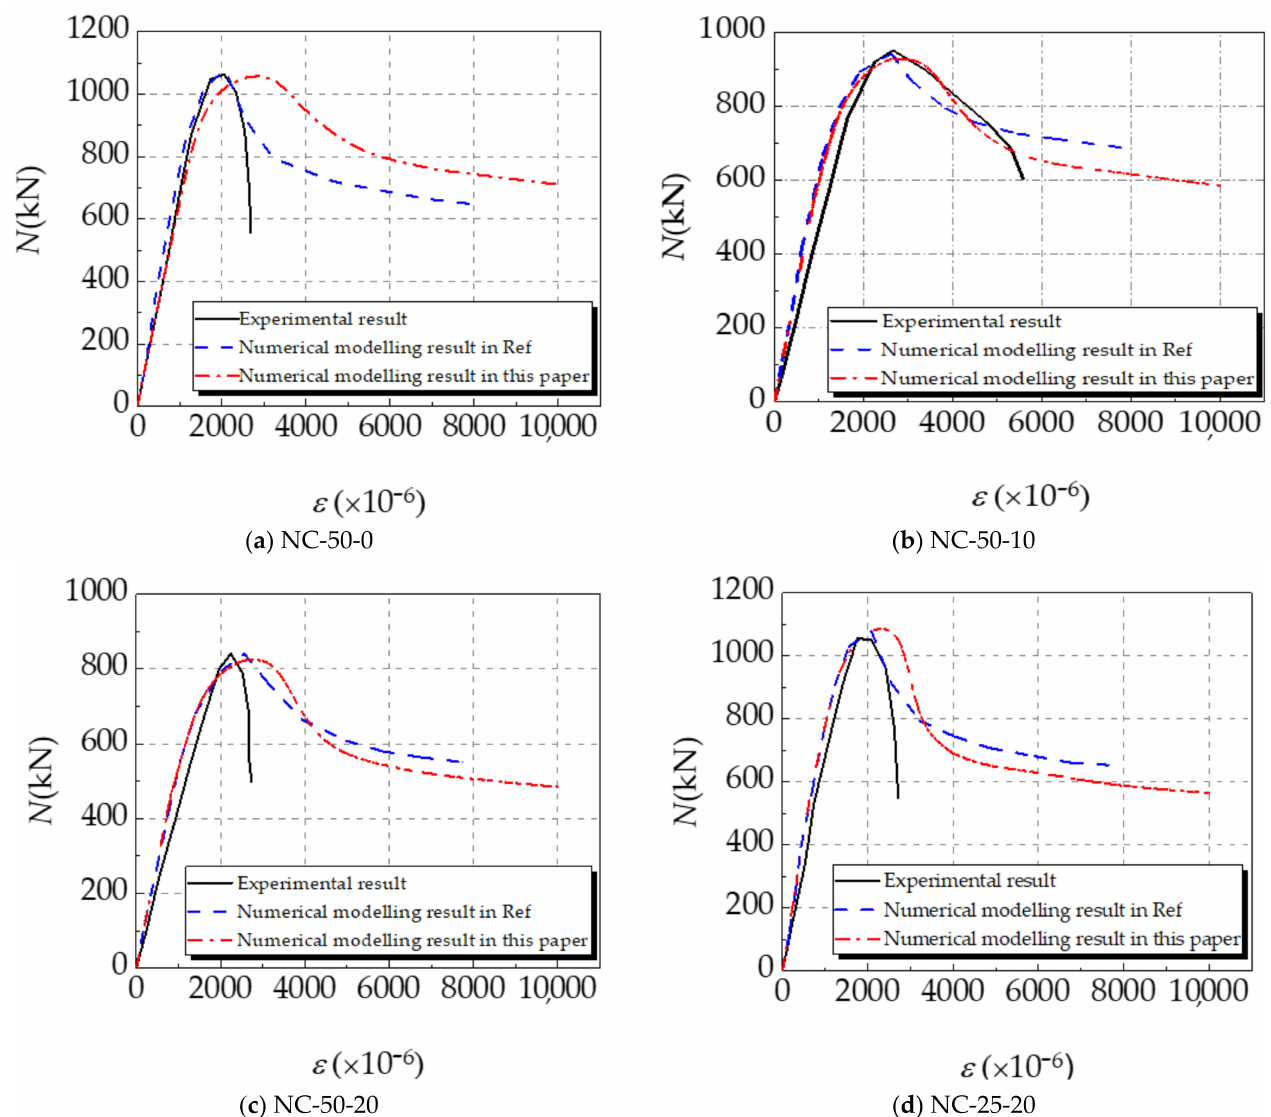
Figure 2. Simulation verification results of Ref. [34]. ( a ) NC-50-0; ( b ) NC-50-10; ( c ) NC-50-20; ( d )